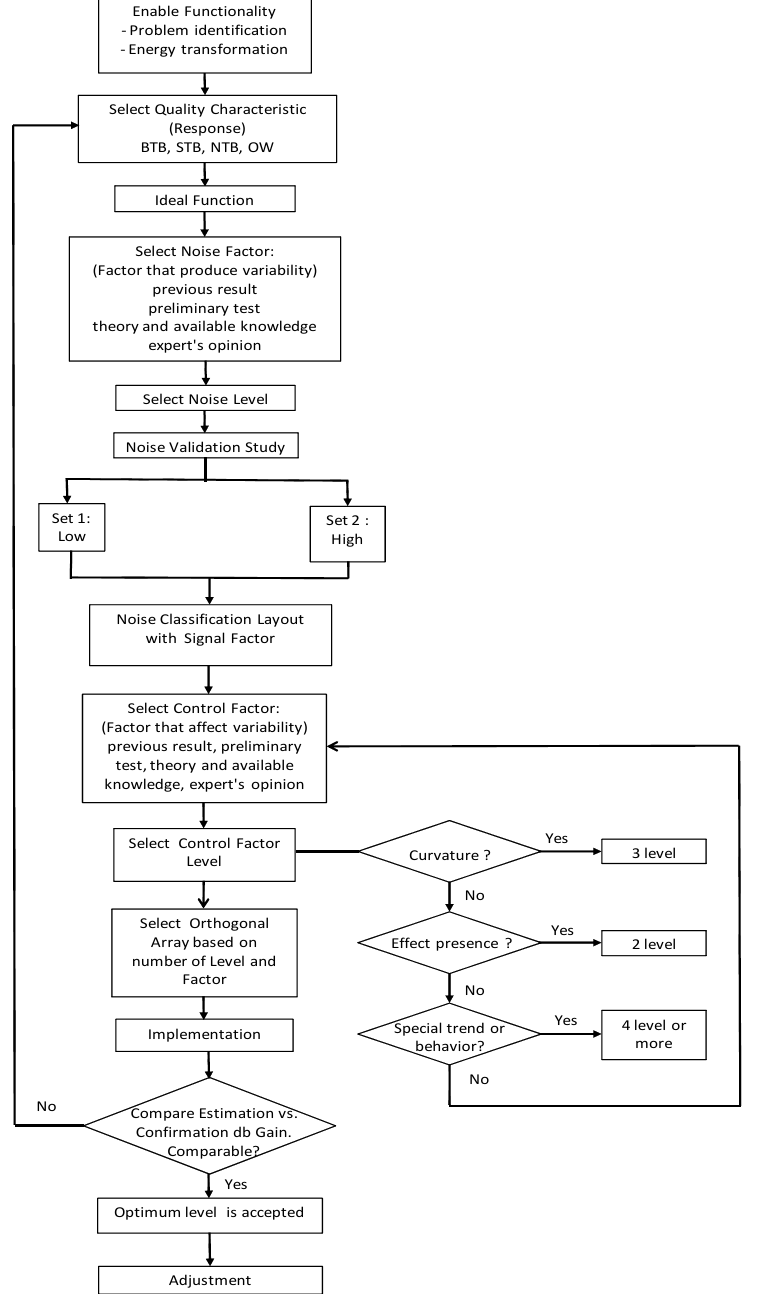
Figure 16. Methodology flow for robust measurement system.